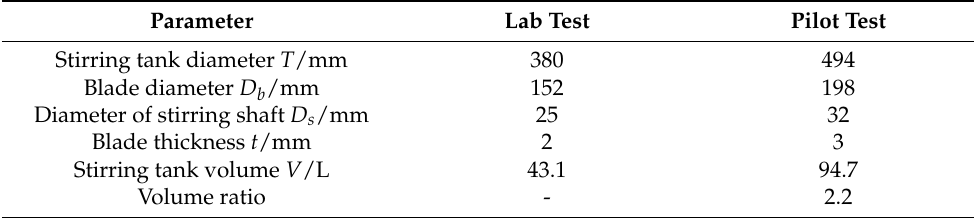
Table 2. Structural parameters of different